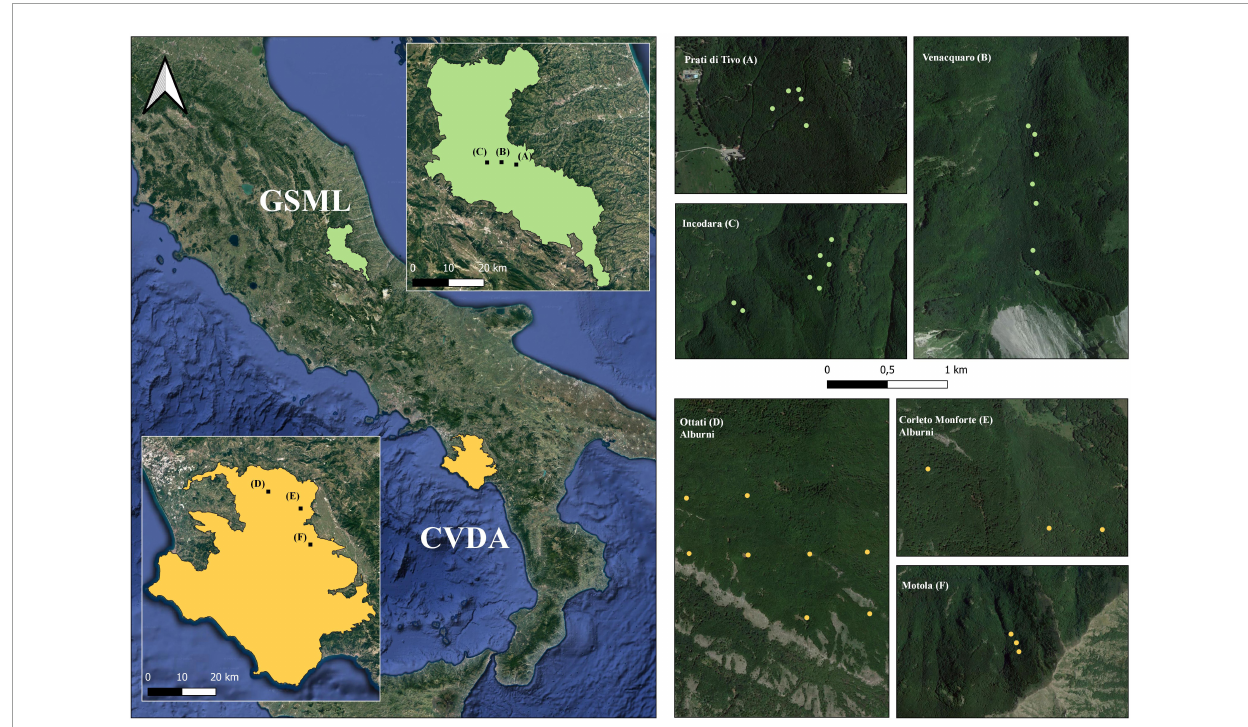
FIGURE1 On the left, the National Parks where the study areas are located (GSML, Gran Sasso e Monti della Laga National Park; CVDA, Cilento, Vallo di Diano e Alburni National Park). In the magnification, black dots represent the study areas investigated in each park: in GSML, “Prati di Tivo”, “Venaquaro”, and “Incodara”; in CVDA, “Ottati”, “Corleto Monforte”, and “Motola”. On the right, the green and yellow dots represent the locations of the plots sampled in GSML and CVDA, respectively.